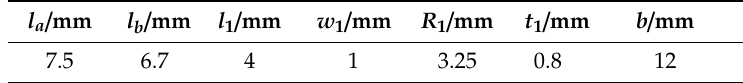
Table 2. Main parameters of the high-rigidity four-bar (HRFB) mechanism.